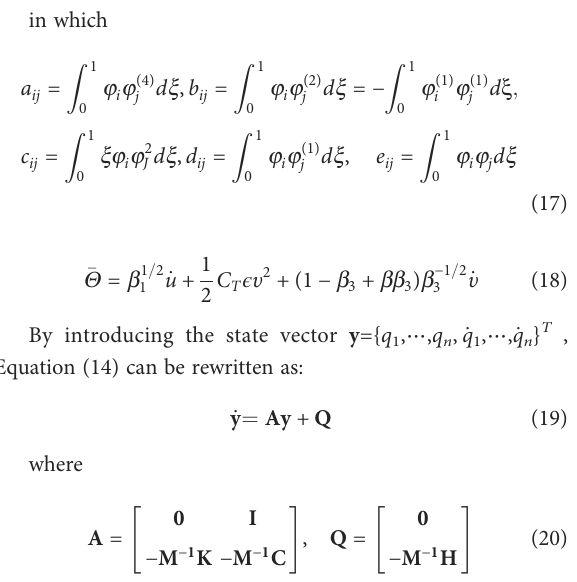
algorithm for solving non-linear ODEs of complex